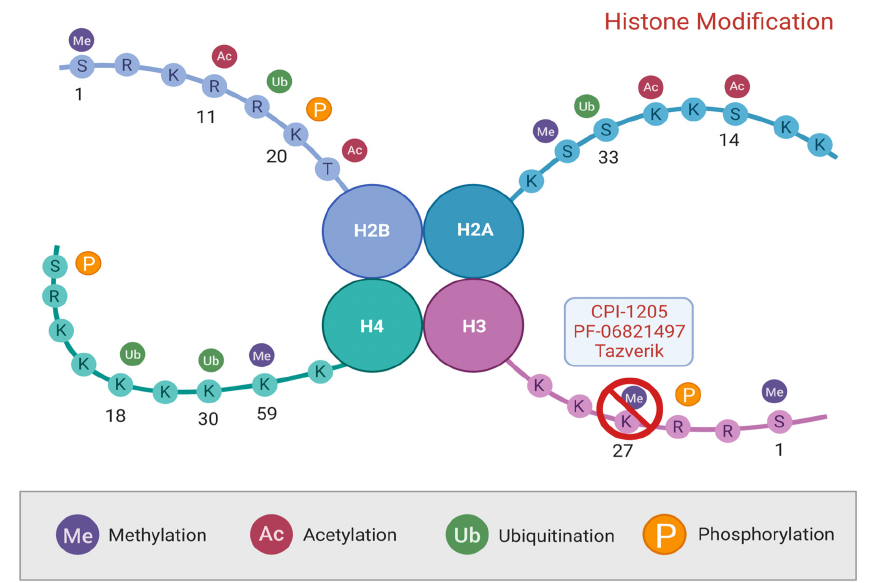
Figure 3. Mechanism of action of the EZH2 inhibitors CPI-1205, PF-06821497, and Tazverik. EZH2 is an enzyme responsible for methylation of histone H3 at lysine 27. Created with BioRender.com (11 March 2023).